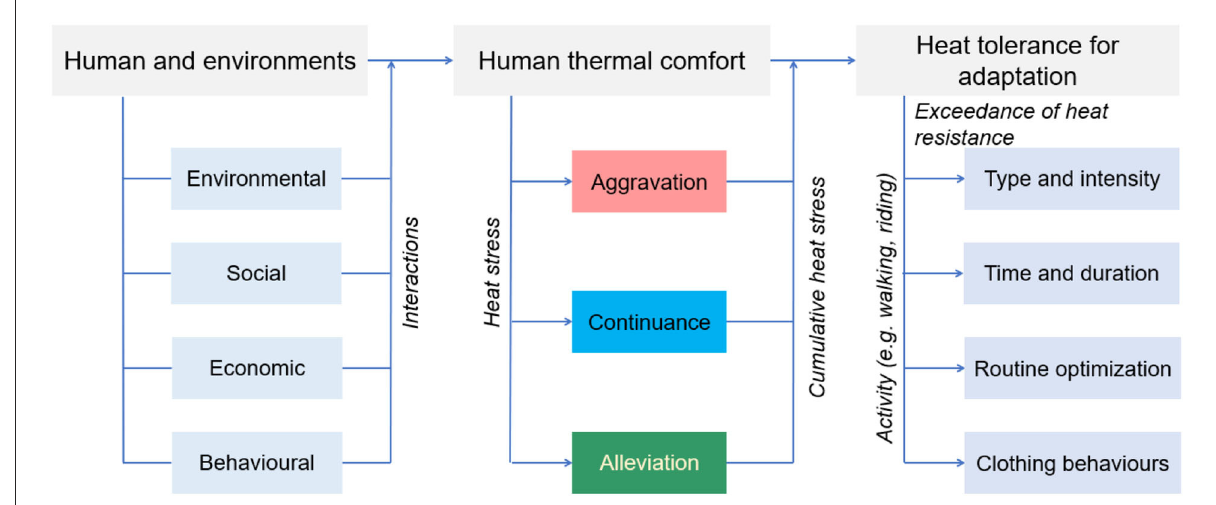
FIGURE3 Association between heat tolerance and human-environmental characteristics.